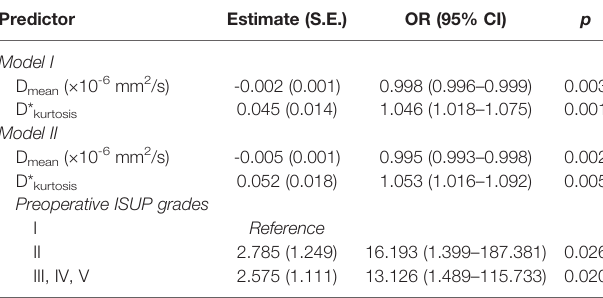
TABLE 4 | Multivariable analysis of signi fi cant predictors of high-risk group according to radical prostatectomy specimens using logistic regression analysis. Predictor Estimate